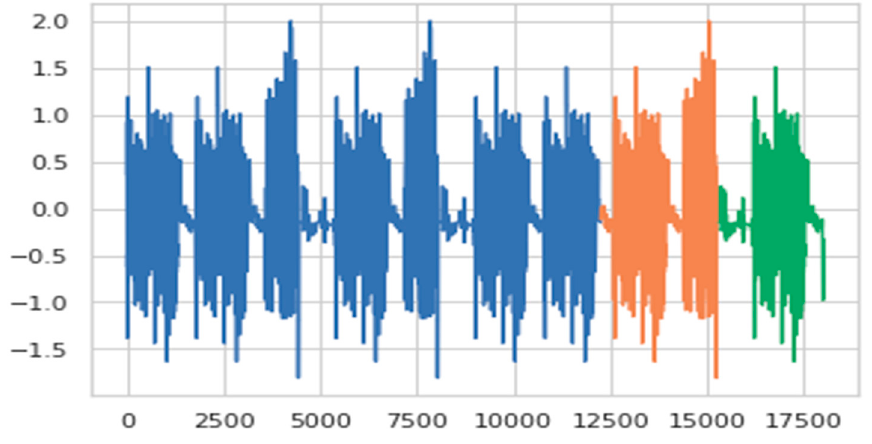
Figure 6. Accelerometer (x-axis) data samples for Ascending Stairs activity.